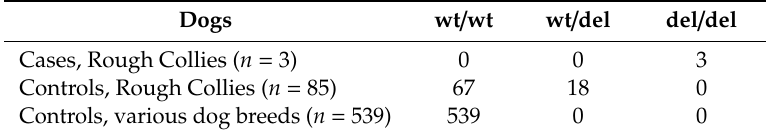
Table 2. Genotype-phenotype association of the AKNA :c.2717_2720delACAG variant. Dogs wt / wt wt / del del / del Cases, Rough Collies ( n = 3) Controls, Rough Collies ( n = 85) Controls, various dog breeds ( n =